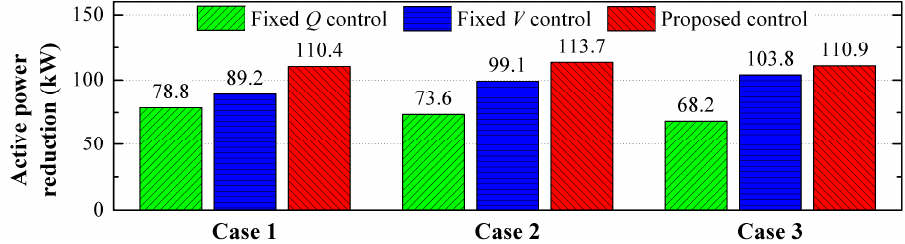
Figure 12. Average reduction of the active power drawn from substation: two ‐ DG system.